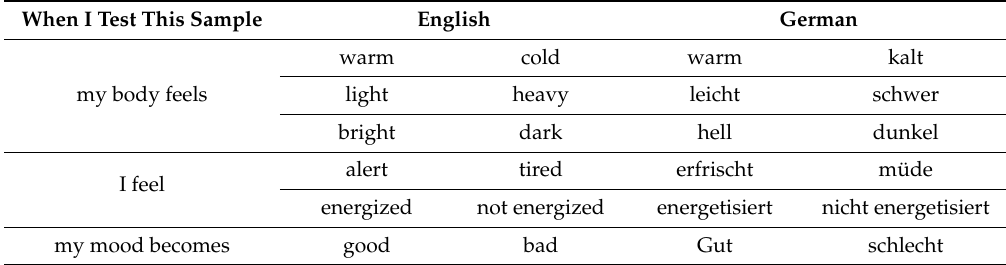
Table 4. The six bipolar items, rated on five points, that were used as the wellbeing parameters to measure consumers’ food-related